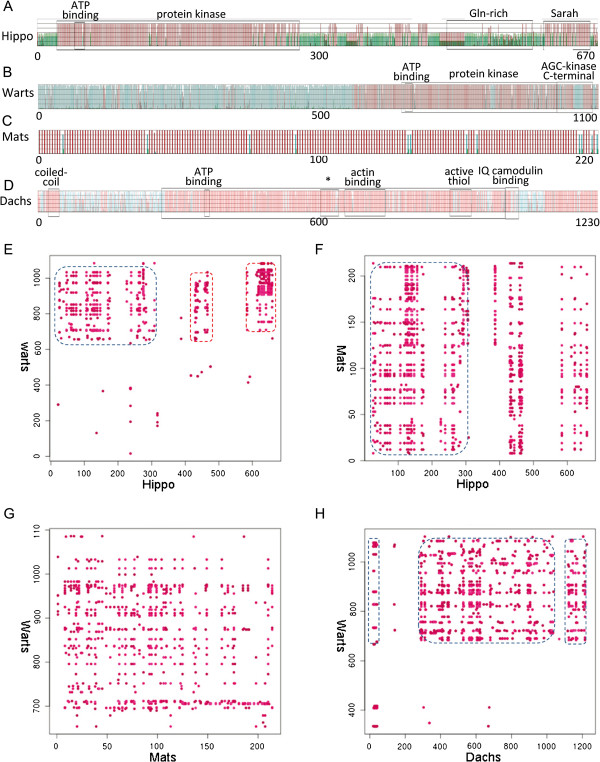
Most functional domains in Hippo genes are under purifying selection and have coevolved with other functional domains. (ABCD) are Drosophila Hippo, Warts, Mats and Dachs, with the number of amino acids marked below. Red, blue and green bars indicate sites under purifying selection, neutral evolution and positive selection, and black frames indicate identified functional domains. In (D) the symbol * indicates the “unique insert in myosin head domain” and the big frame from 274 aa to 1025 aa indicates “myosin head domain”. In (EFGH) red dots indicate coevolved sites in two genes. (E) Hippo’s 20–300 aa coevolve with Warts’s 600–900 aa (marked by the dashed black box); these two regions correspond to Hippo’s protein kinase domain and Warts’s protein kinase domain. Hippo’s 440–470 aa coevolve with Warts’s 600–900 aa; the former does not correspond to any identified domain in Hippo but the latter corresponds to the protein kinase domain. Also, Hippo’s 580–650 aa coevolve with Warts’s 640–1100 aa; these two regions largely correspond to Hippo’s Sarah domain and Warts’s AGC-kinase C-terminal domain. (F) Hippo’s 20–300 aa coevolve with the whole Mats (marked by the dashed black box), indicating that the whole Mats may be under purifying selection. (G) While coevolution signals occur evenly in the whole Mats, they exist only in Warts’s 700–1000 aa. This region in Warts corresponds to its protein kinase domain, which is under purifying selection. (H) Sites under purifying selection in Dachs (the coiled-coil domain, the myosin head domain, and the tail domain) coevolve with sites under purifying selection in Warts (the protein kinase domain). Notably, Dachs’s tail domain is under strong purifying selection and coevolves with Warts’s protein kinase domain (marked by the black boxes).